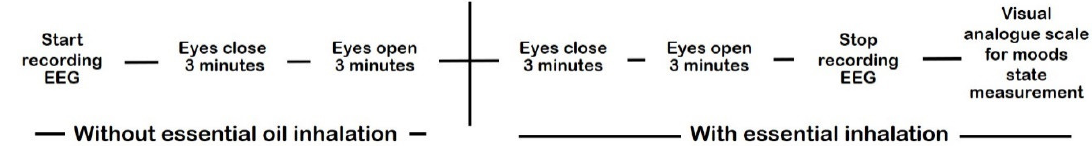
Figure 12. Experimental procedure divided into two trials: with and without essential oil inhalation. Three odors were applied for a volunteer with repeated protocols.